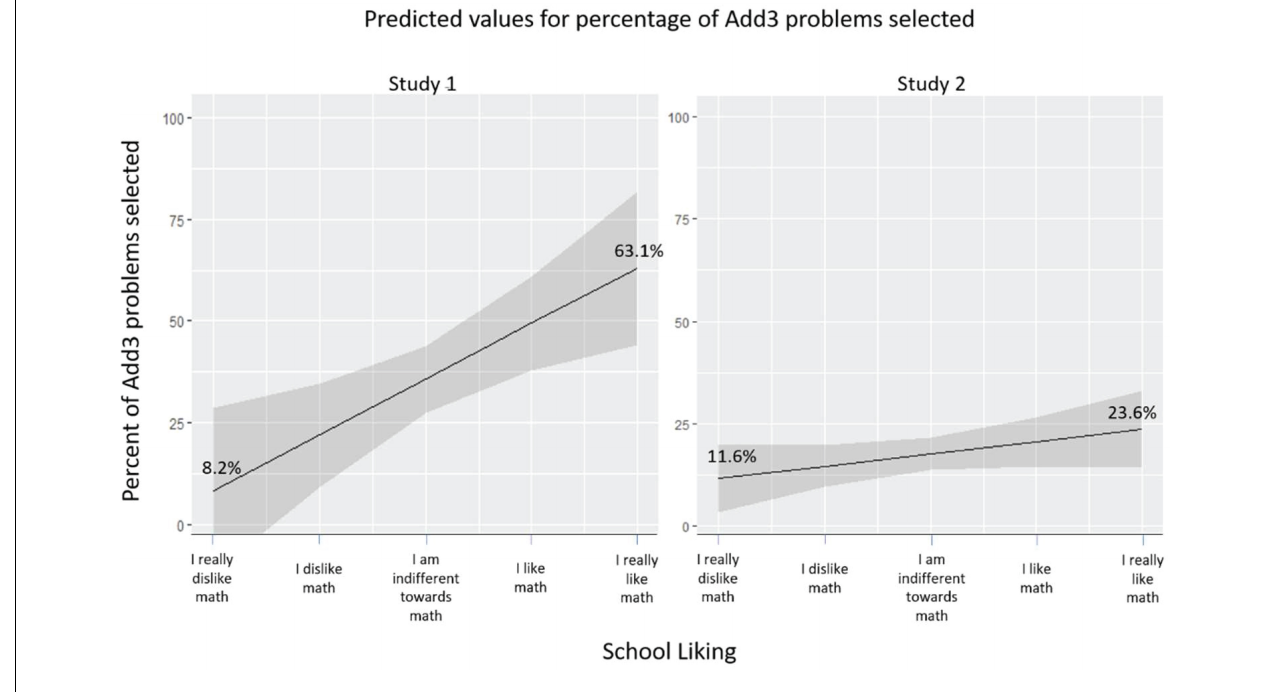
FIGURE 2 | Predicted means for Studies 1 and